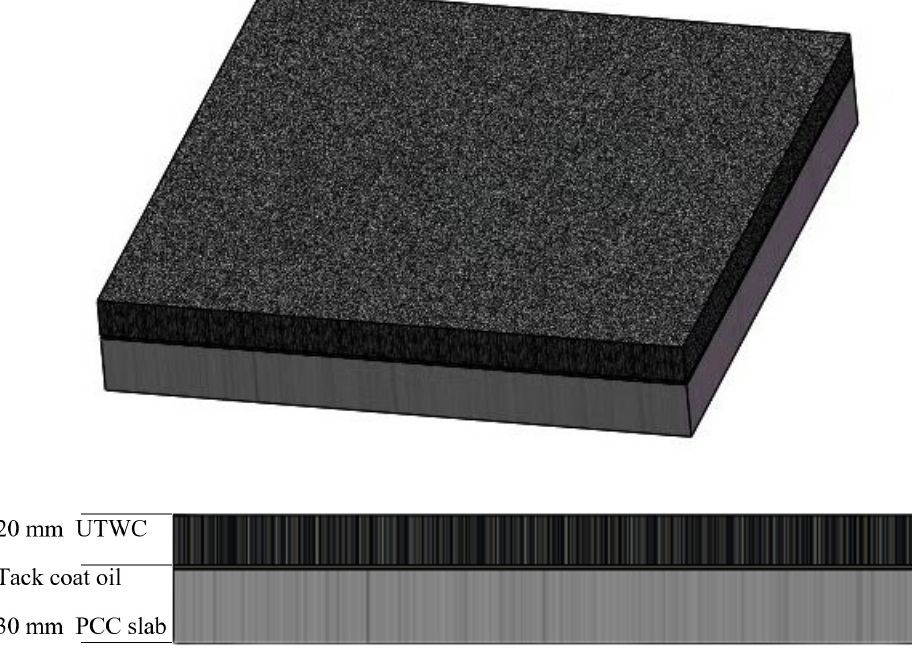
Figure 5. The 3D view and front view of the composite